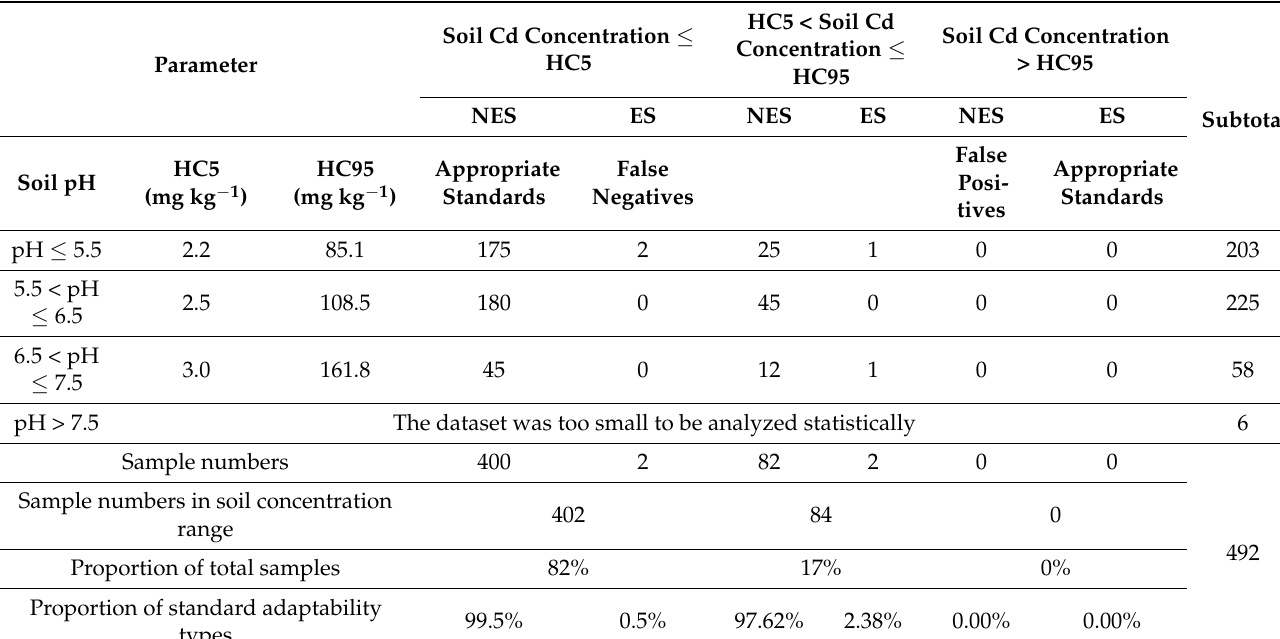
Table 4. Suitability analysis of the hazardous concentrations for 95% and 5% crop safety (HC5 and HC95) for evaluating soil contamination of agricultural lands for the classification of soil environ- mental quality in the research